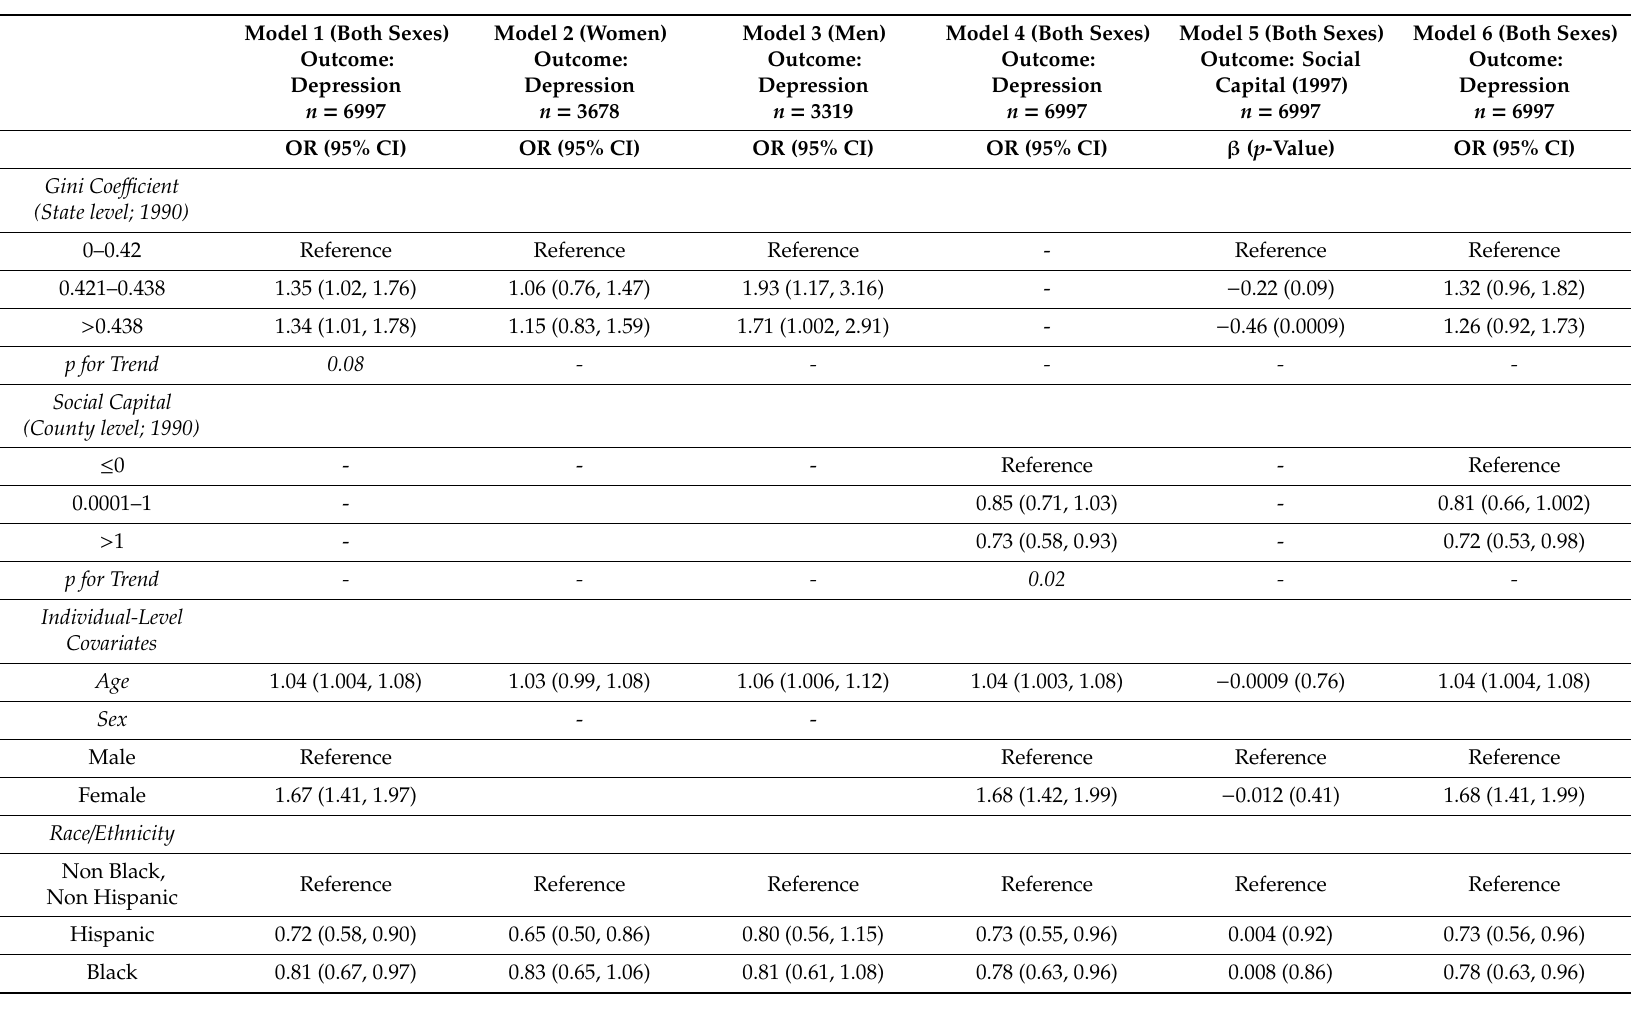
Table 2. Coe ffi cient estimates from multivariable logistic regression analysis of state-level income inequality, county-level social capital, and individual-level